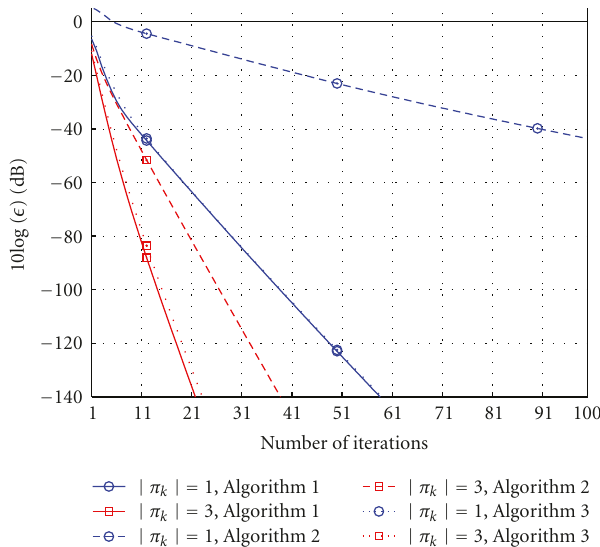
Figure 11: Comparison of convergence speed of di ff erent algo- rithms.